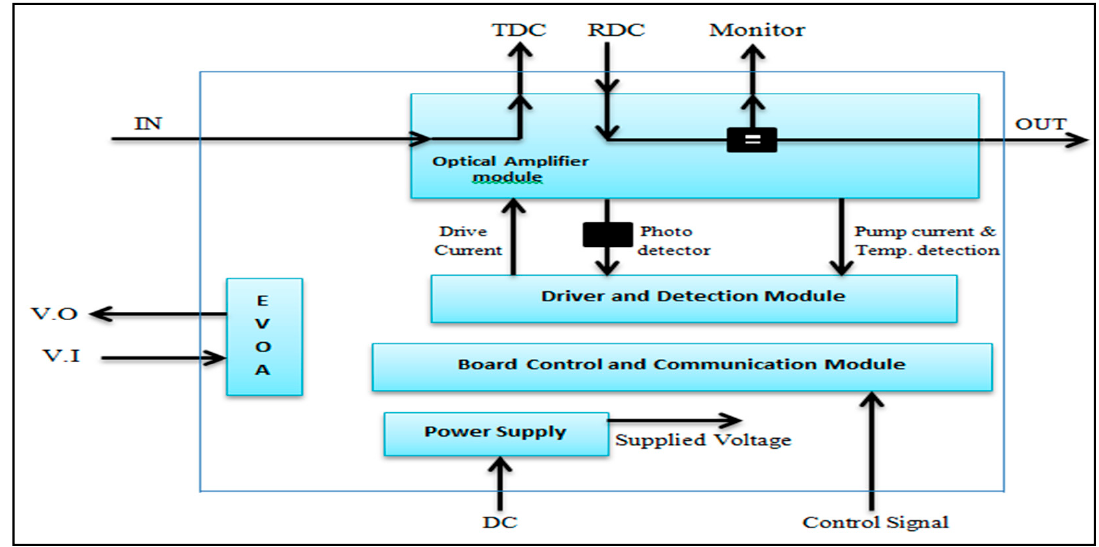
Figure 3. Block diagram of the optical amplifier board before modern FPMT detecting circuit was added in two-way transmitter and receiver sides.